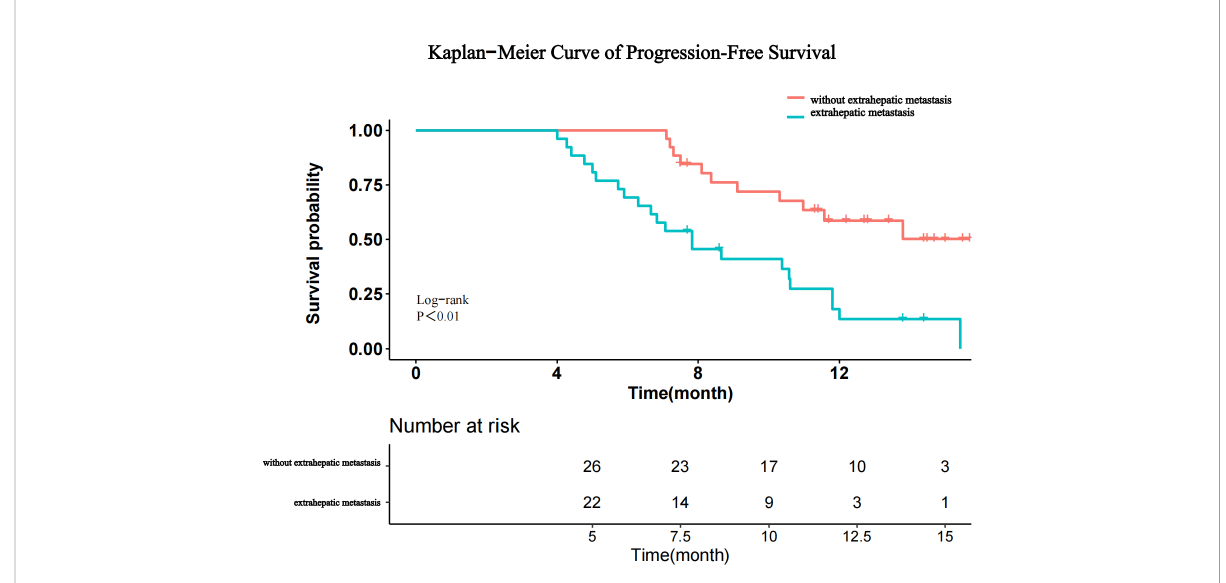
FIGURE 5 Kaplan – Meier curves for progression-free survival after strati fi cation by the absence or presence of extrahepatic